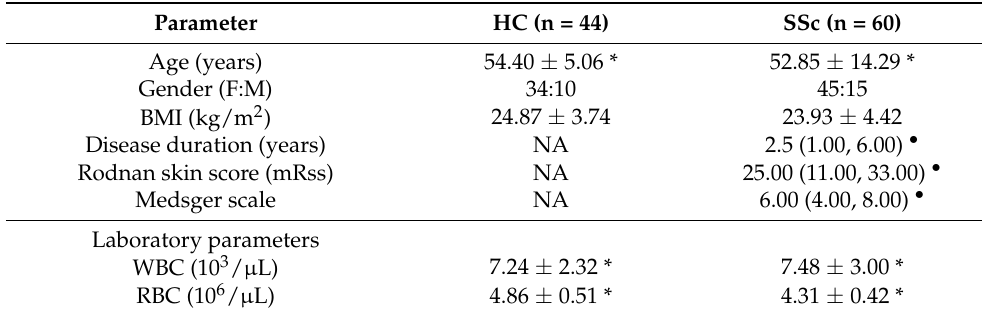
Table 1. Demographic, clinical and treatment characteristics of systemic sclerosis patients and healthy